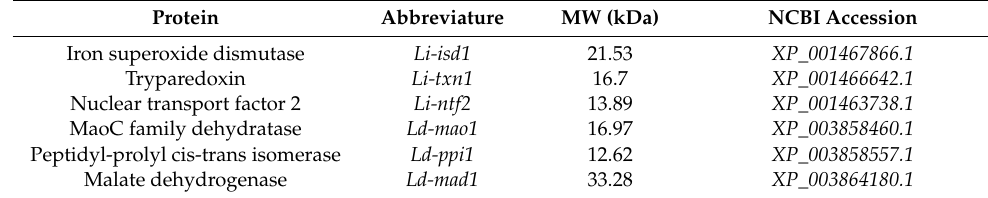
Table 1. Leishmania infantum / donovani proteins found in urine of patients with viscera